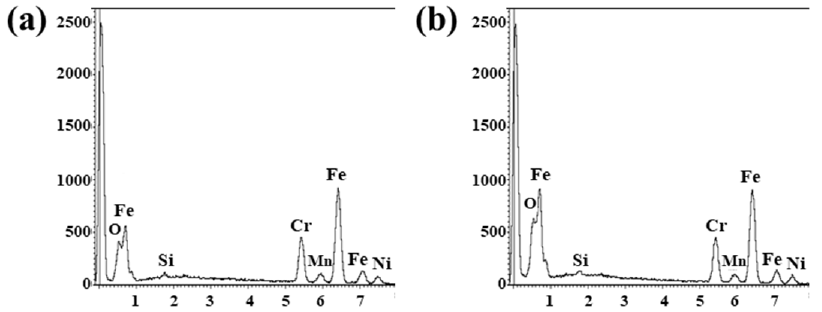
Figure 6. EDS analysis of ( a ) plate-like debris and ( b ) blocky debris collected at the end of wear tests at a rotation speed of 200 rpm under dry contacts.